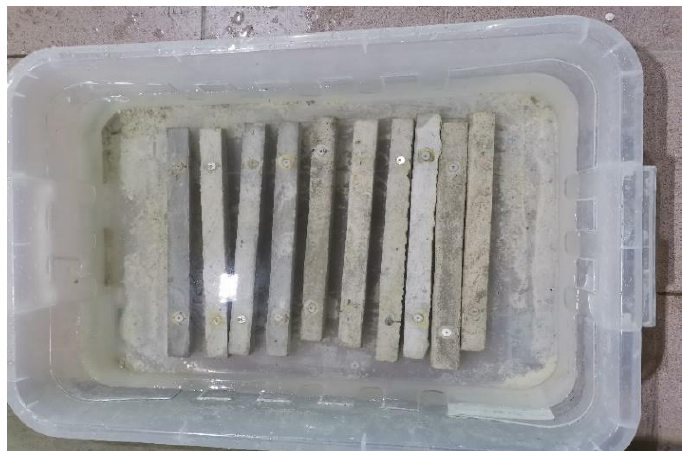
Figure 5. Expansion specimens.